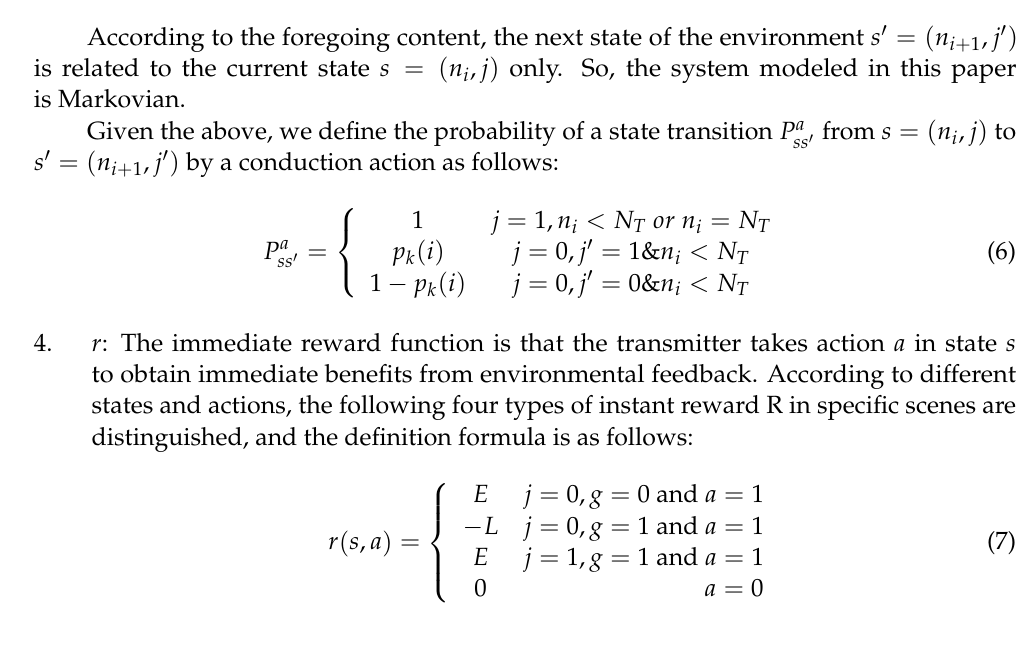
Figure 2. Schematic diagram of the elements in this model. ( a ) Schematic diagram of the state parameters; ( b ) State transition diagram; ( c ) Diagram of the immediate reward function; ( d ) Schematic diagram of the time slot structure.